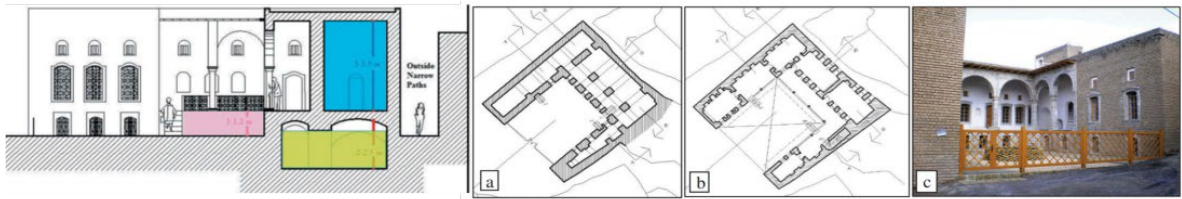
Figure 6. Detail of a heritage building in the citadel with historical value. ( a ) Basement floor plan. ( b ) Ground floor plan. ( c ) View of the building. Buildings 2023 , 13 , x FOR PEER REVIEW